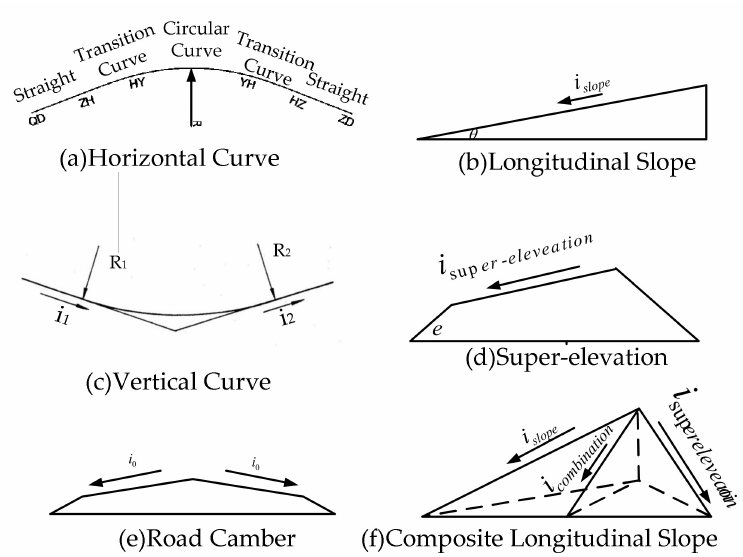
Figure 1. Road geometric parameters. ( a ) horizontal curve; ( b ) longitudinal slope; ( c ) vertical curve; ( d ) super-elevation; ( e ) road camber; ( f ) composite longitudinal